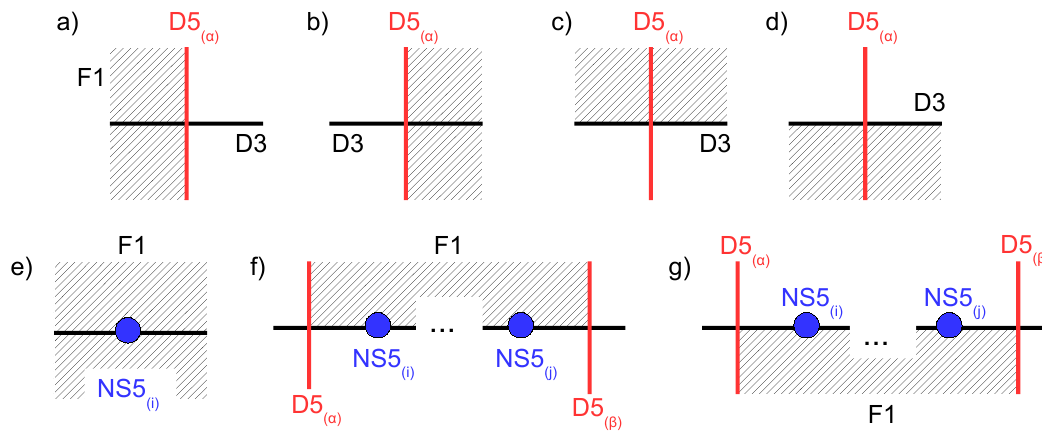
Figure 37 . Setups with F1 strings inserting HB operators (mesons). The insertions are: